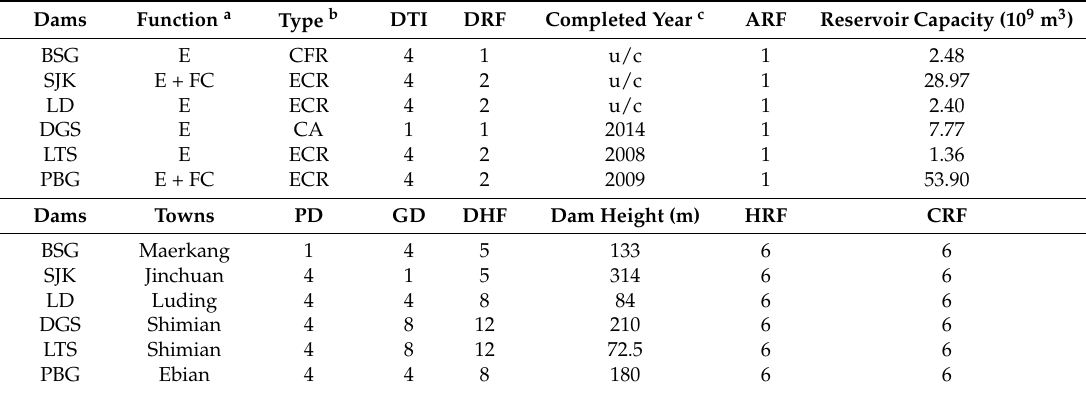
Table 8. Properties of dams considered for this